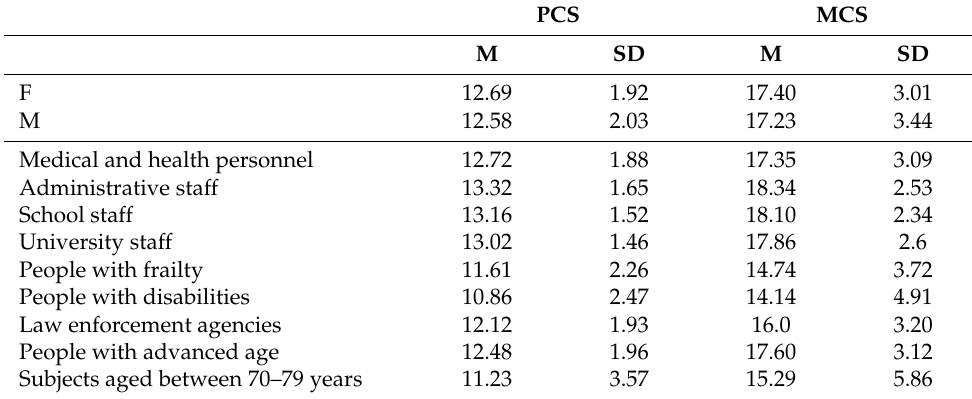
Figure 4. Percentage of response frequencies relative to items of STAI-Y divided by vaccine priority ministerial categories. Table 8. Mean (M) and standard deviation (SD) of the scores obtained on the PCS and MCS scales of the SF-12 relating to the gender and vaccine